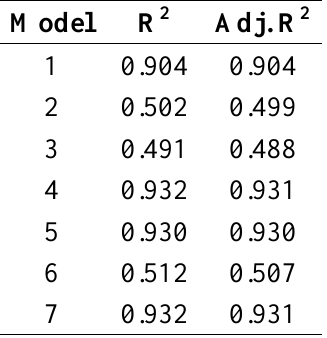
Table 9. Goodness-of-fit of the